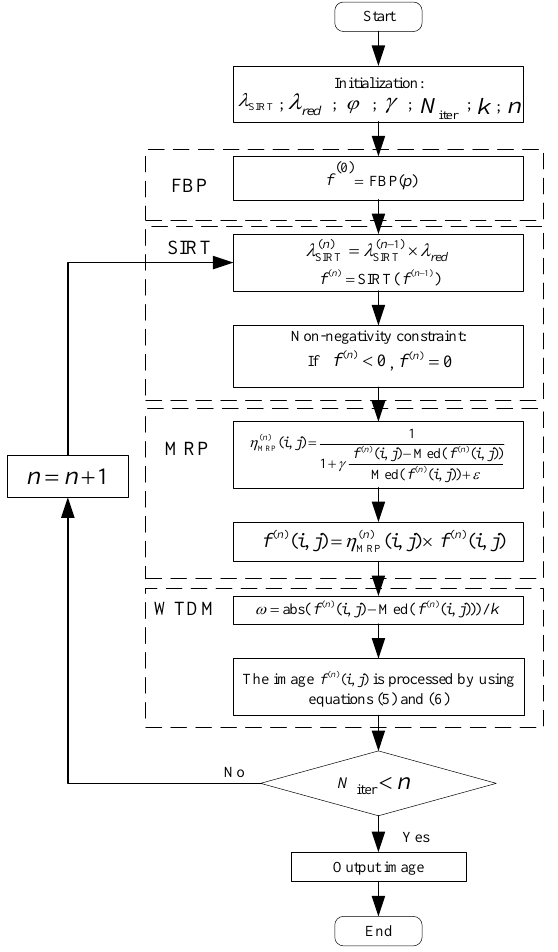
Figure 1. Organizational scheme of the SIRT-MWTDM algorithm. In the organizational scheme, λ SIRT is the relaxation factor. λ red is a decay ratio. ϕ is the weight value between gradient continuity and gradient sparsity constraints. γ is the noise suppression intensity parameter. N iter is the maximum number of iterations. k is a parameter to adjust the threshold ω . n is the number of tions. Algorithm 1 The organizational scheme of the SIRT-MWTDM